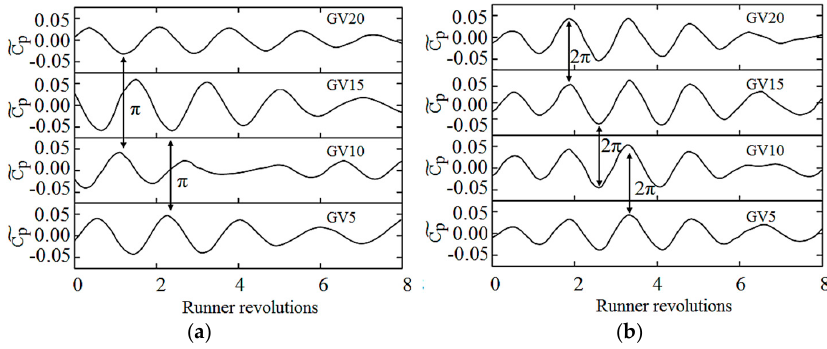
Figure 13. Band-pass-filtered pressure. ( a ) Runaway point OP5; and ( b ) low-discharge point OP6.